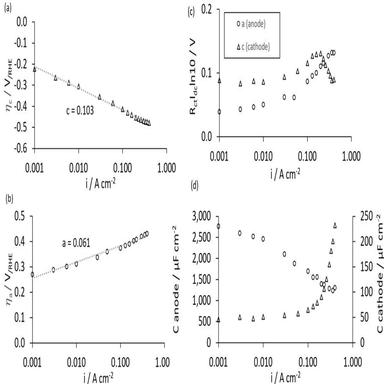
A) ηc obtained by IR correction of measured electrode potential b) ηa obtained by IR correction of measured electrode potential and subtraction of Ea e ; c) Tafes slopes (RCT Iln10) as a function of current density for anode and cathode. d) Capacitance (C) values for anode and cathode as a function of current density.